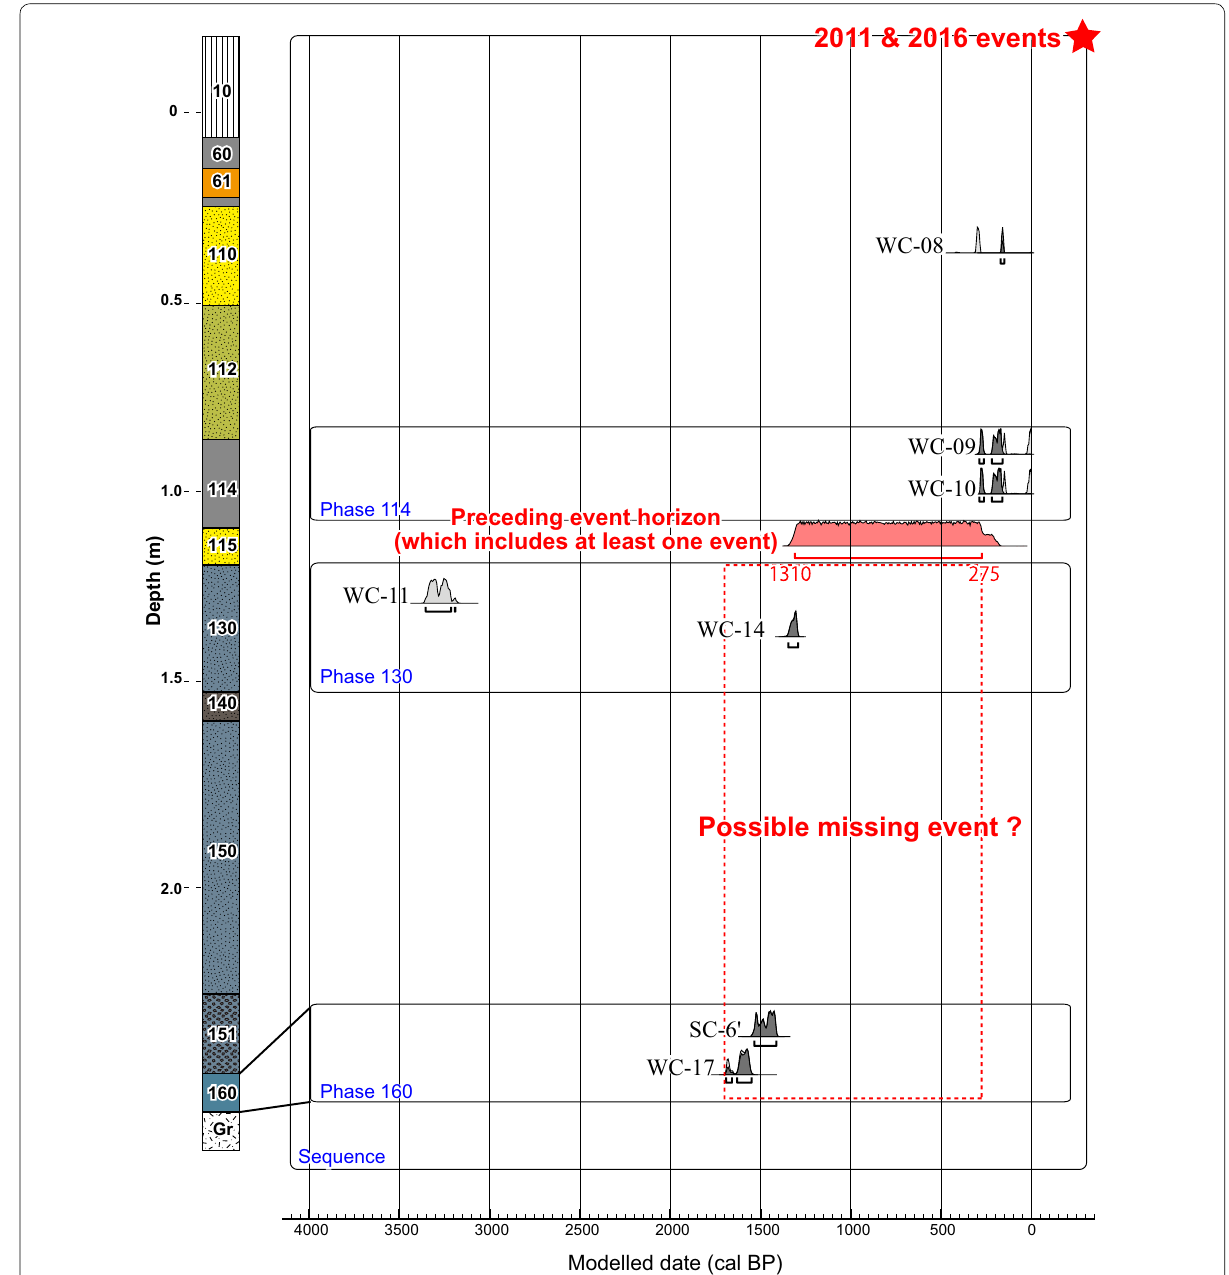
Fig. 8 Age–depth plot showing the constrained probability density distribution of radiocarbon ages in a synthesized stratigraphic column of the west wall of the Mochiyama trench (Fig. 7b), made with OxCal v4.3.2 software (Bronk Ramsey 2017). Light-gray curves are the original probability density distribution of radiocarbon ages, and dark-gray curves are density distributions refined by Bayesian analysis. The red curve is the probability distribution of the age of the preceding event as constrained by radiocarbon ages. The blue outlines labeled “Phase” enclose all radiocarbon ages from each stratigraphic unit, and the outline labeled “Sequence” defines the order of events and groups of radiocarbon ages (Bronk Ramsey